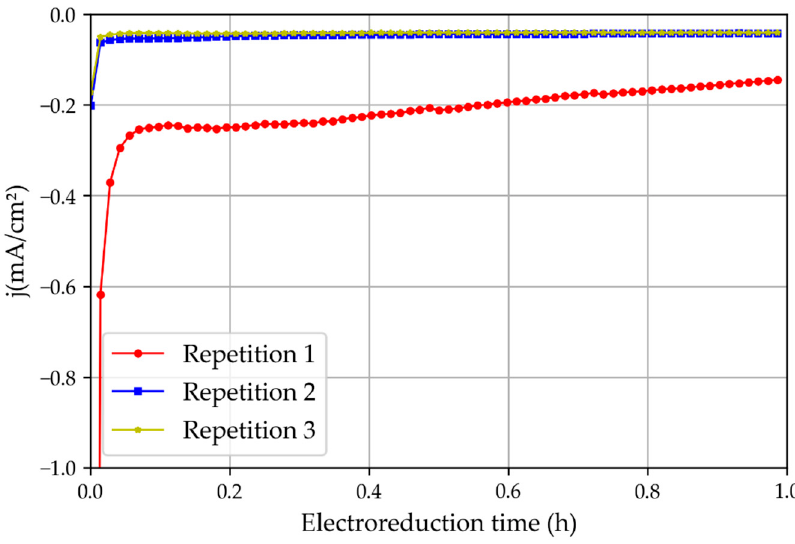
Figure 8. Three repetitions of the chronoamperometric test using a non-treated tin catalyst oxidated in the atmosphere and the 3D printed reactor.